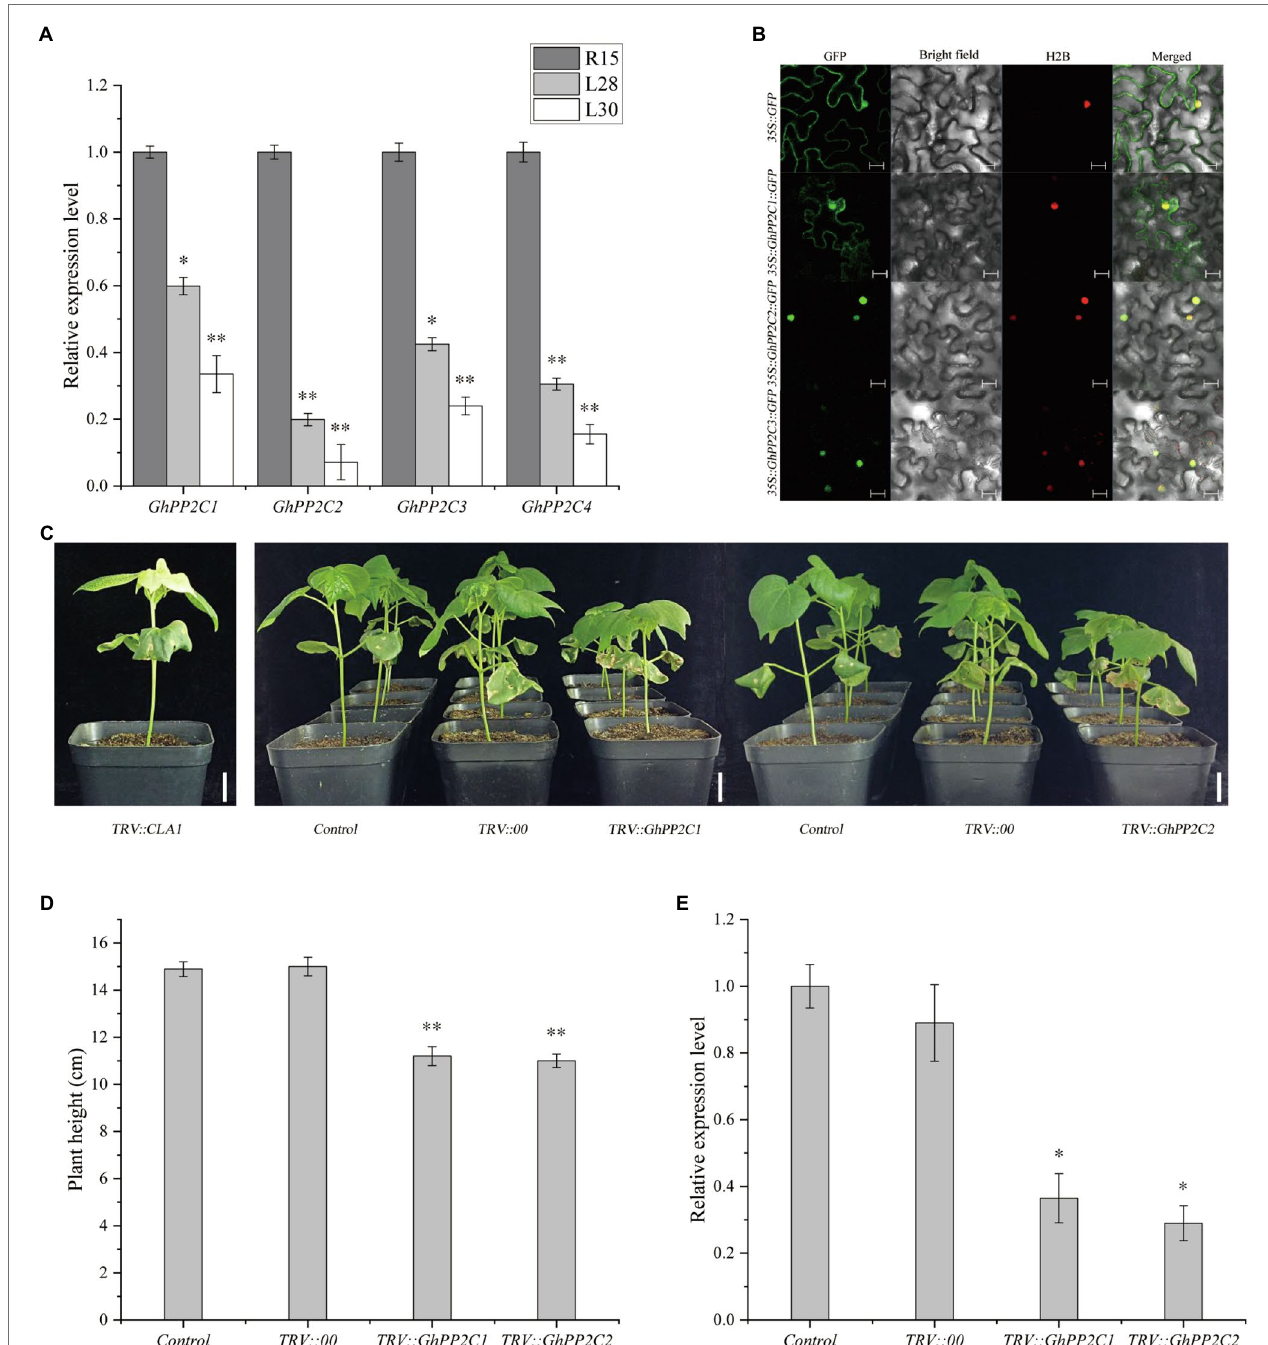
FIGURE 4 | Preliminary analysis of GhPP2C gene functions. (A) Expression of four GhPP2C genes in cotton R15, L28, and L30 seedlings. (B) Subcellular localization of GhPP2C proteins. Fluorescence of GhPP2C1-GFP, GhPP2C2-GFP, and GhPP2C3-GFP fusion proteins and GFP (negative control) was detected at 488 nm by confocal microscopy with H2B-mCherry as the nucleolus marker; images were merged (Merged). Scale bar = 20 μ m. (C) Plant phenotype after VIGS silencing of GhPP2C1 or GhPP2C2 in R15. TRV:: CLA1 , albino phenotype, positive control; Control, not treated; TRV::00, empty vector control. Scale bar = 2 cm. (D) Plant height after silencing of GhPP2C1 and GhPP2C2 . (E) Gene expression assay after silencing of G hPP2C1 or GhPP2C2 . Error bars indicate the standard error ( n = 3 biological replicates). * p < 0.05, ** p < 0.01 (Student’s t